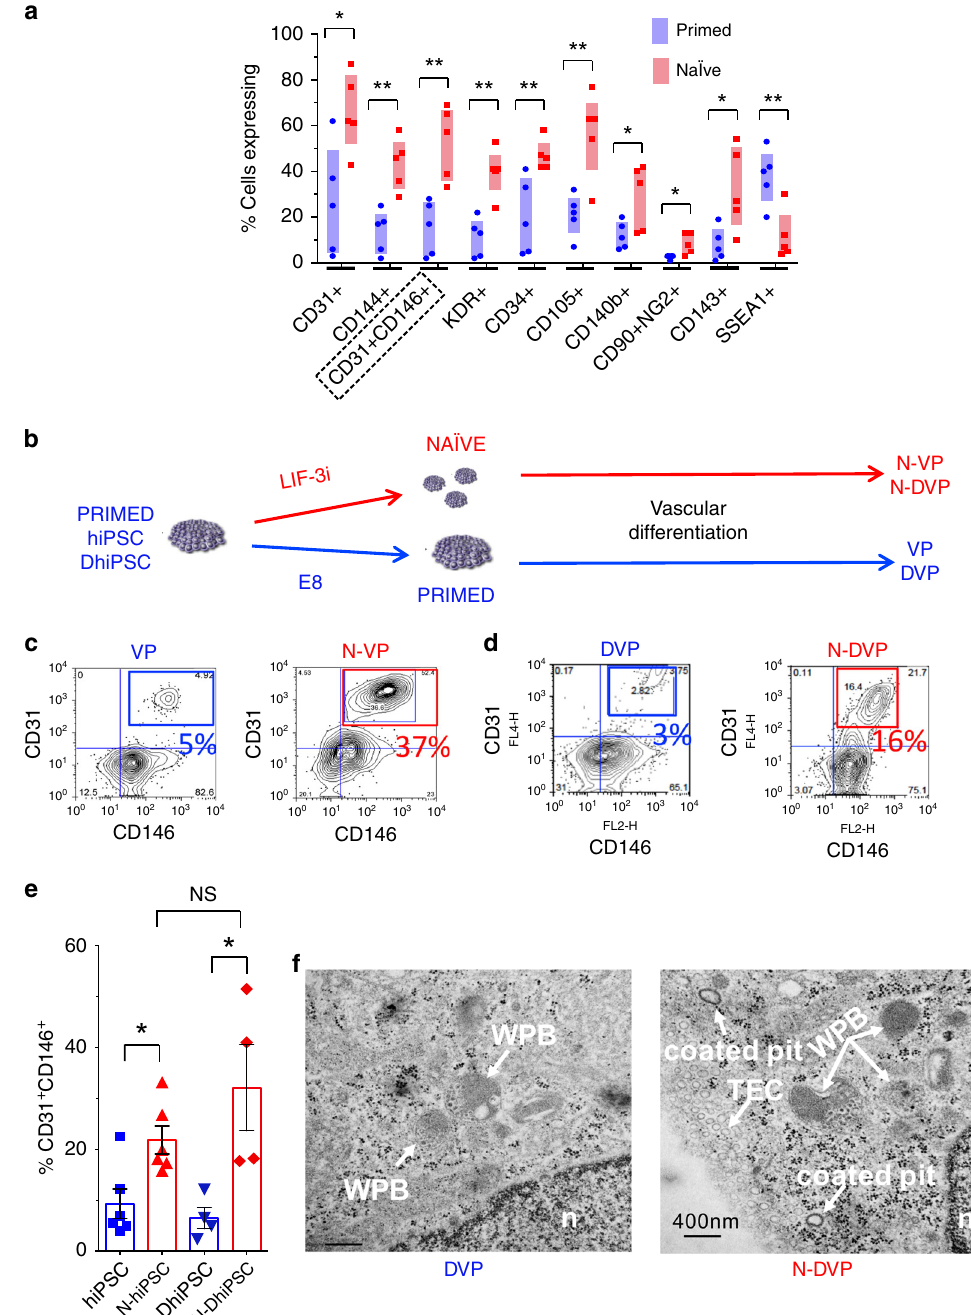
Fig. 3 Vascular differentiations of primed vs. naïve non-diabetic and diabetic hiPSC. a Vascular-lineage differentiation of non-diabetic isogenic primed vs. naïve hiPSC ( n = 5 lines; Supplementary Data 1). Shown are % cells quantitated by fl ow cytometry on Day 10 differentiation cultures 7 expressing surface markers for endothelial-vascular progenitors (e.g., CD31 + , CD34 + , CD144 + , CD31 + CD146 + , KDR + ), pericytes (e.g., CD140b + , CD90 + NG2 + ), angioblasts (e.g., CD105 + , CD143 + ), and non-vascular-lineage markers (e.g., SSEA1 + ). * p < 0.05; ** p < 0.01 (two-tailed unpaired t -tests). b Schematic of experimental design for CD31 + CD146 + DVP differentiation of isogenic primed vs. naïve sibling hiPSC/DhiPSC. DhiPSC/hiPSC were directly differentiated (without need for an additional re-priming or capacitation step) in parallel APEL vascular conditions for 8 – 10 days. c Representative fl ow cytometry analyses of isogenic day 10 differentiations of ( c ) CD31 + CD146 + VP vs N-VP from non-diabetic hESC (RUES02), and d CD31 + CD146 + DVP vs N-DVP from diabetic hiPSC (E1C1). e Average percentages of CD31 + CD146 + primed (blue) and naïve (red) VP cells obtained from isogenic day 8 – 10 differentiations of non-diabetic (E5C3) and diabetic hiPSC (E1CA1, E1CA2). * p < 0.05 (unpaired two-tailed t -tests). f TEM images of primed DVP and N- DVP differentiated and expanded from parallel primed and naïve isogenic conditions of the DhiPSC (E1C1). Weibel-Palade body (WPB), nucleus (n), transcytotic endothelial channel (TEC); Scale Bar = 400